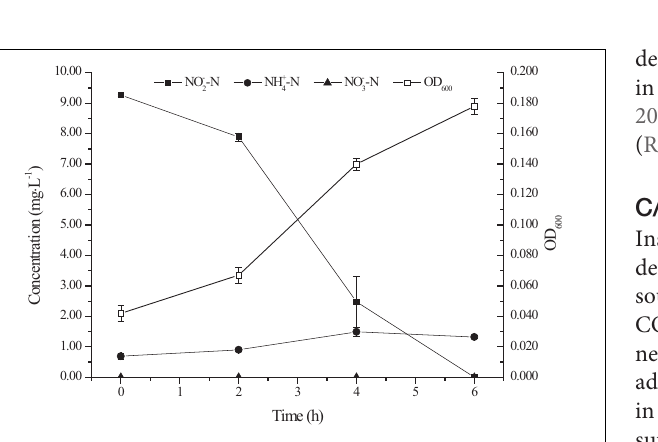
FIGURE 2 | The growth and nitrite removal by strain YT03. Error bars mean ± SD of three